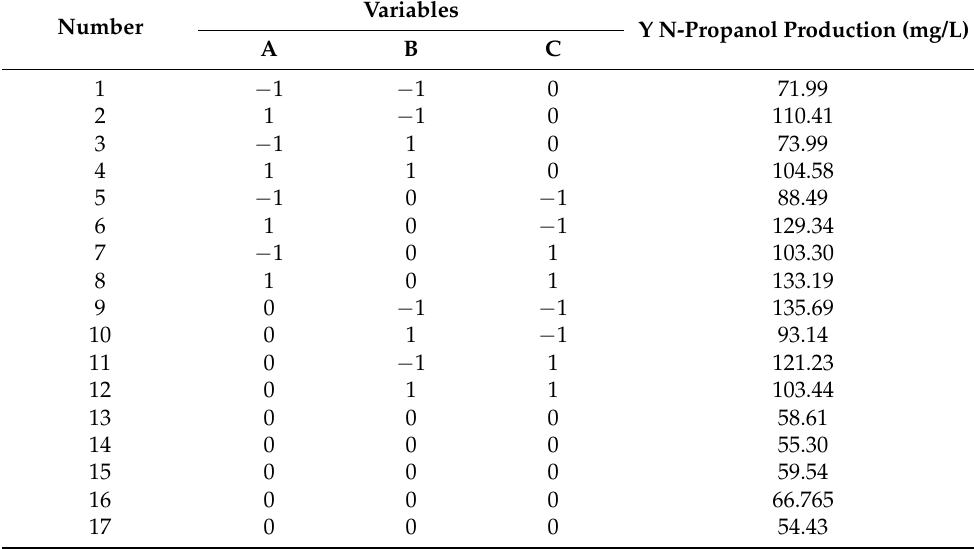
Table 2. Results of response surface